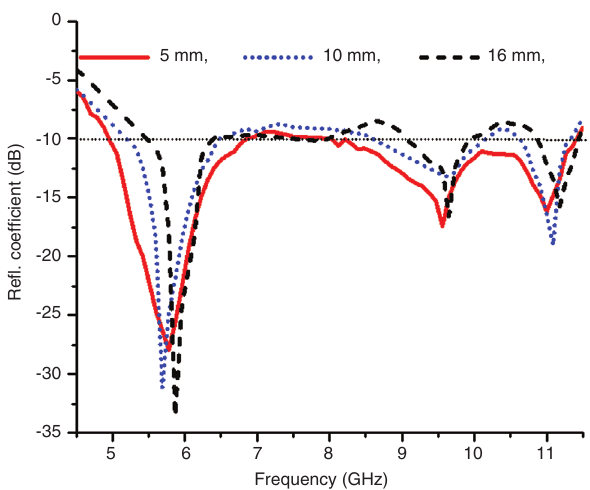
Figure 3 Effect of ground plane length on reflection coefficient of the proposed antenna.